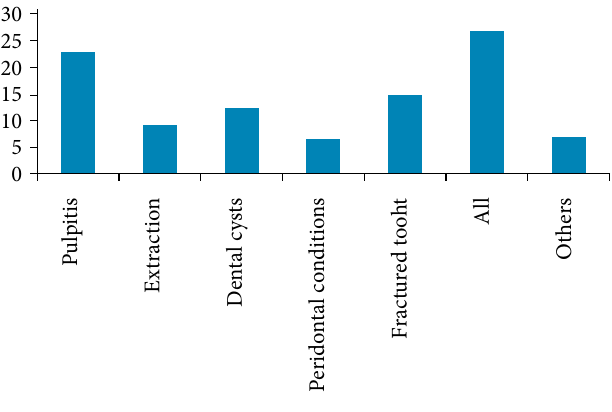
Figure 2. Conditions that need flight restrictions.